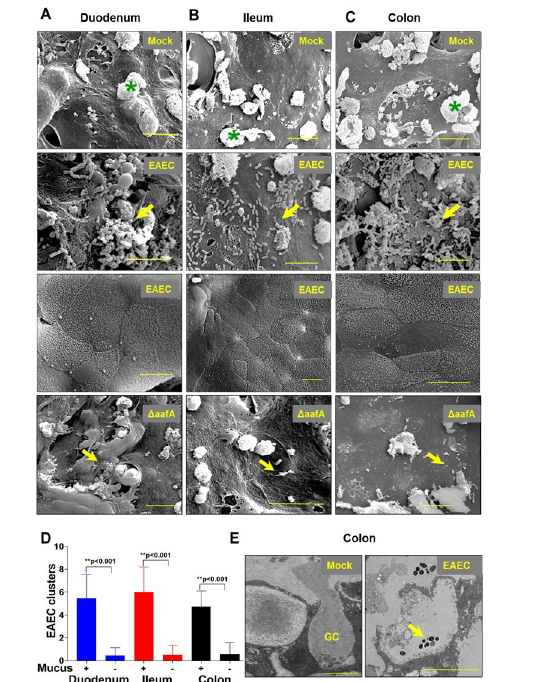
Fig 3. SEM and TEM images of EAEC adherence to human intestinal enteroid monolayers. (A-C) shows SEM image of Mock, EAEC and EAEC: Δ aafA infected duodenal, ileal and colon differentiated HIE monolayers. Row one shows differentiated enteroid monolayers covered by secreted mucus droplets (denoted by the asterisk). Row two shows adherence of EAEC to mucus (yellow arrow) present on the duodenal, ileal and colon monolayers. Row three shows EAEC infected duodenal, ileal and colon monolayers but with no EAEC adherence and without the presence of mucus droplets. Row four shows EAEC: Δ aafA infected duodenal, ileal and colon monolayers. (D) Quantification of the EAEC aggregates in the presence and absence of mucus droplets on enteroid monolayers was quantified from average of 12 images taken at 1700x and error bars denote SEM and ��� indicates significantly different (P < 0.001). (E) TEM of colonoid monolayers showing vesiculation of Goblet Cell (GC) mucus and EAEC adherence to GC mucus (yellow arrow). Scale bars indicate 10 μ m.